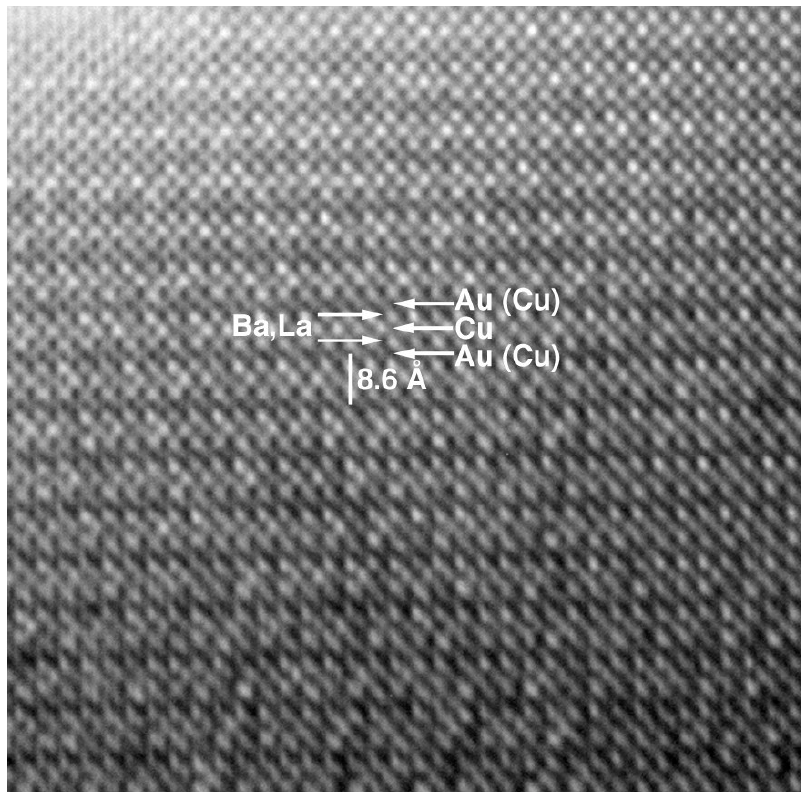
Figure 4. HRTEM image of Au-1201 compounds taken along (010) zone axis. Reproduced with permission from [12].